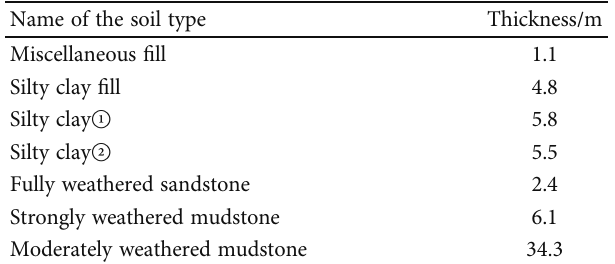
Table 1: Soil layer information of the foundation pit project. Name of the soil